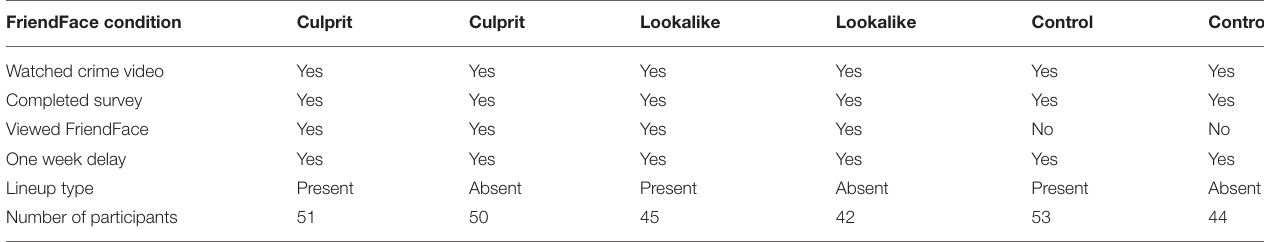
TABLE 1 | Experimental conditions, design, and number of participants. FriendFace condition Culprit Culprit Lookalike Lookalike Control Watched crime